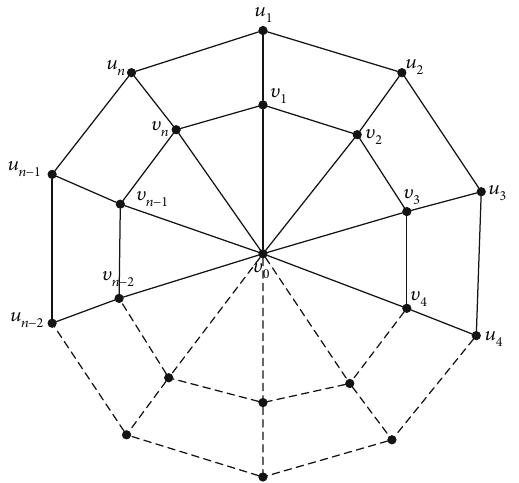
Figure 15: The closed helm CH